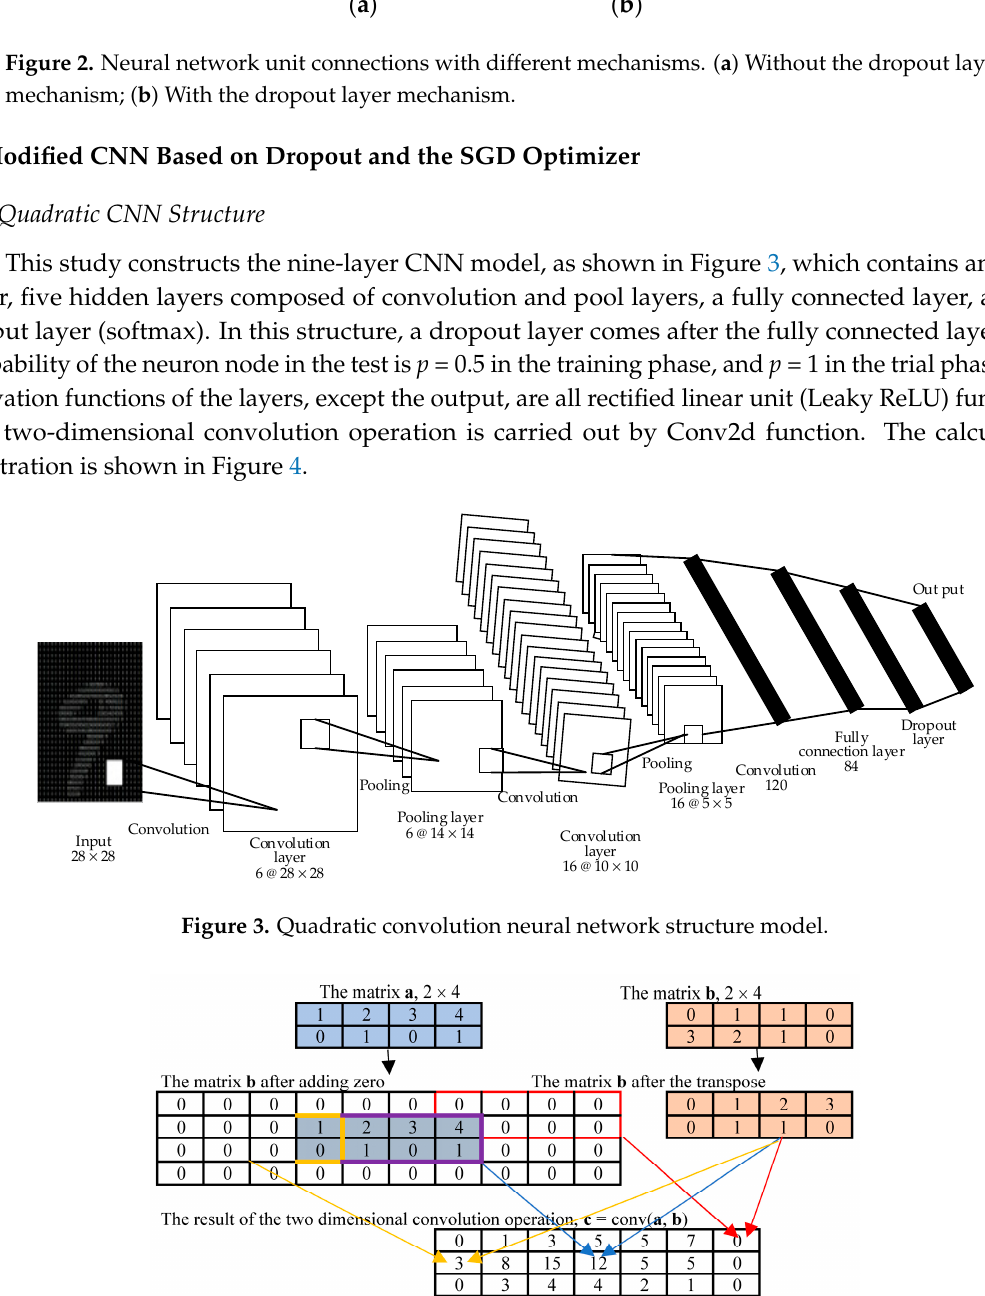
Figure 4. Illustration of the two-dimensional convolution operation process.